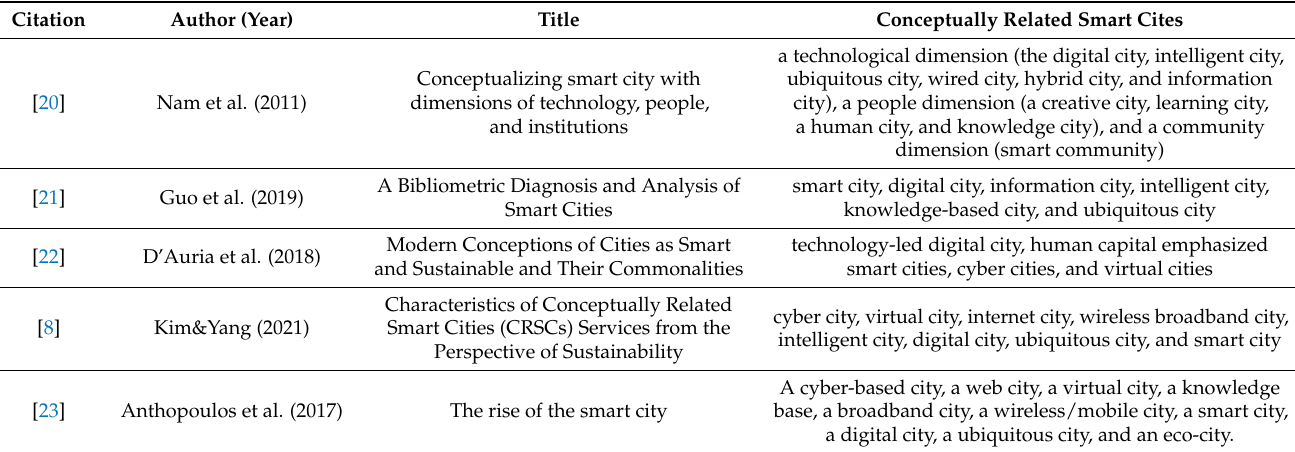
Table 1. The names of Conceptually Related Smart Cites in the existing